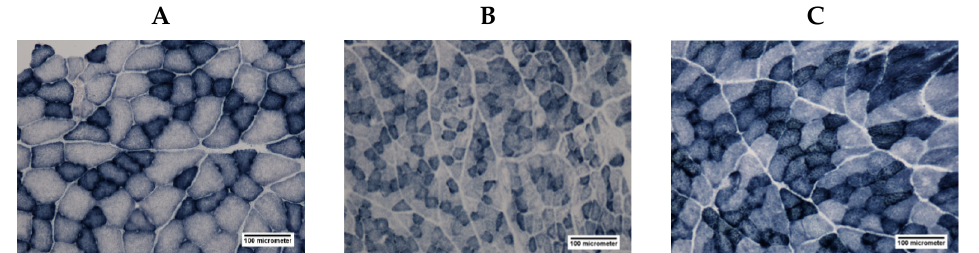
Figure 6. Photomicrographs of cross-sections through the extensor digitorum longus (EDL) muscle of the normal rats fed a control diet (NOC group) ( A ), diabetic rats fed a control diet (DMC group) ( B ), and diabetic rats fed the non-extractable fraction of dried persimmon (NEP) diet (DMP group) ( C ) stained with succinate dehydrogenase. ( A – C ) are shown at the same magnification, and the scale bar at the bottom right of each figure is 100 µm.